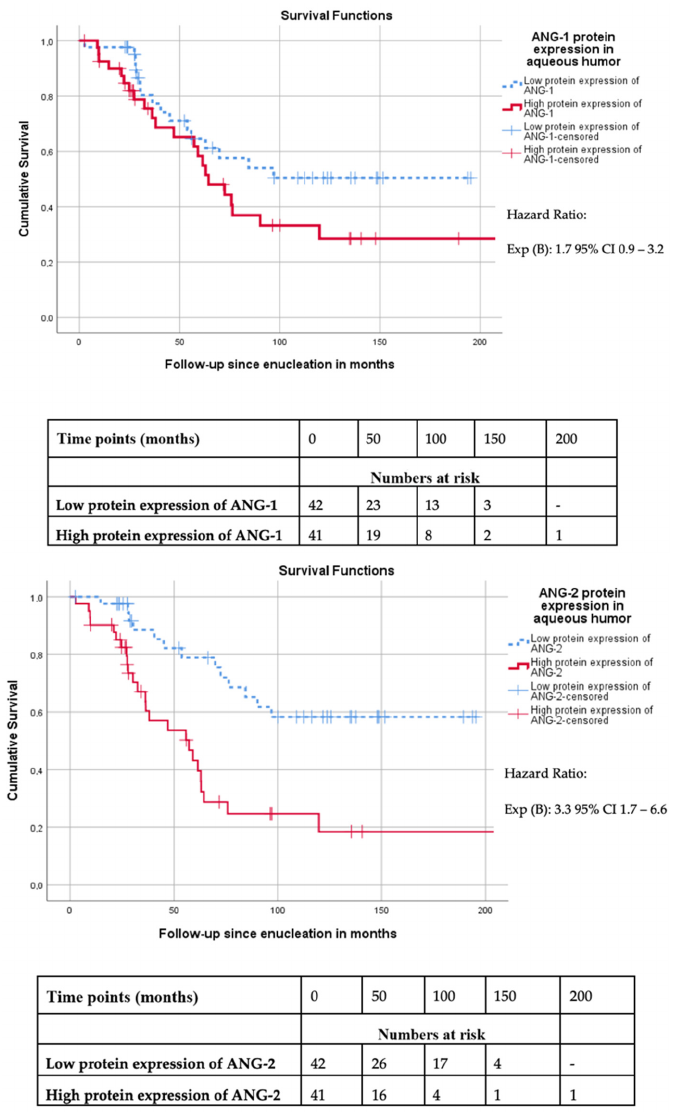
Figure 2. ( A ) Survival curve of UM-related survival dichotomized according to the median of ANG-1 expression levels in the aqueous humor ( n = 83, Log Rank p = 0.11). ( B ) Survival curve of UM-related survival dichotomized according to the median of ANG-2 expression levels in the aqueous humor ( n = 83, Log Rank p < 0.001).